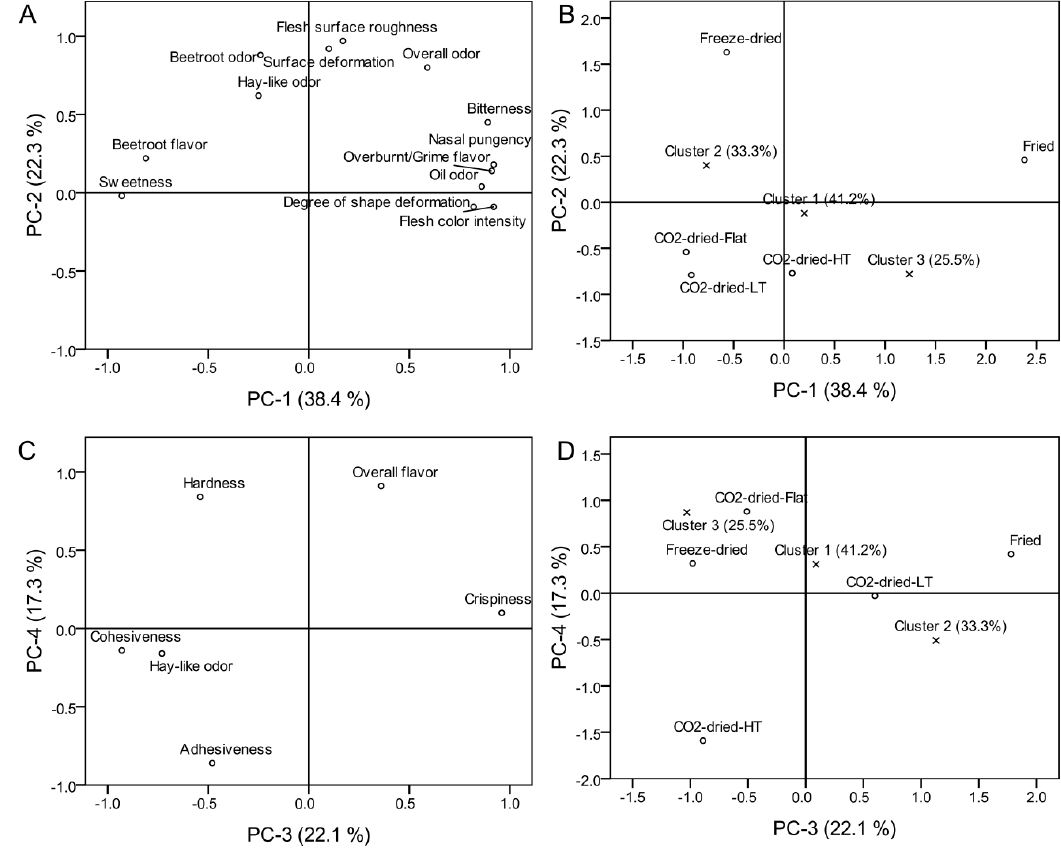
Figure 2. Four-dimensional principal component-space (PC-1 to PC-4) of the sensory descriptive data (10 assessors × 2 replications) of dried beetroot samples, previously subjected to generalized Procrustes analysis, regressed against the overall hedonic data (PREFMAP). ( A , C ): loading plots; ( B , D ): scores plots. Loadings cutoff was set at 0.60. Consumers (N = 102) are grouped within the three clusters. Samples abbreviations: “Flat” = not pre-cooked, flat cuts; “LT” = not pre-cooked, wavy cuts; and “HT” = pre-cooked, wavy cuts.